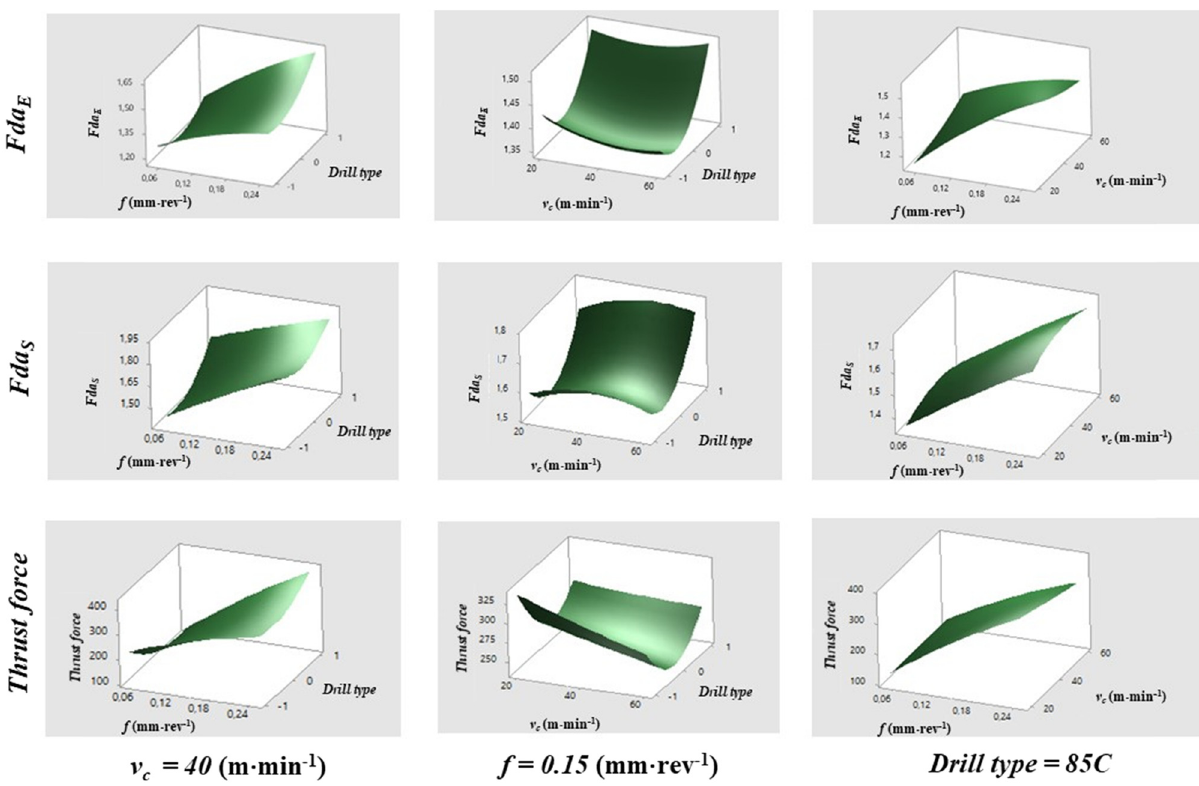
Figure 4: 3D surface plot of response